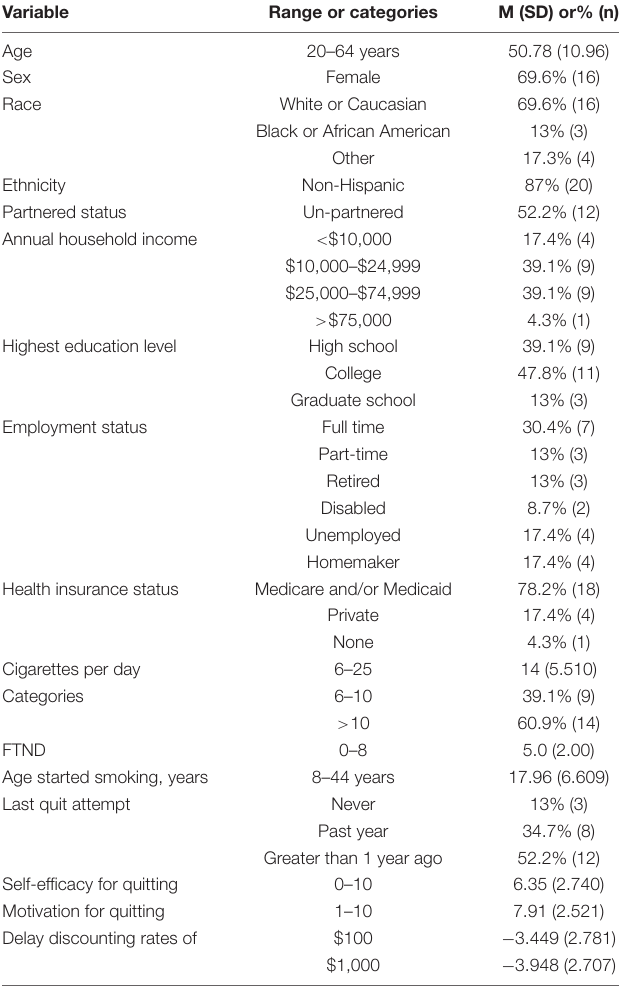
TABLE 1 | Participant ( n = 23) characteristics at